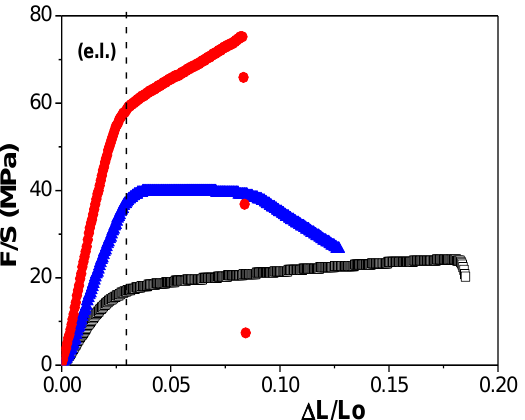
Figure 4. Normal tensile stress versus strain for the RC/BMIMPF 6 film ( ● ), the RC/AliquatCl film ( ▼ ) and the RC- support film (□).